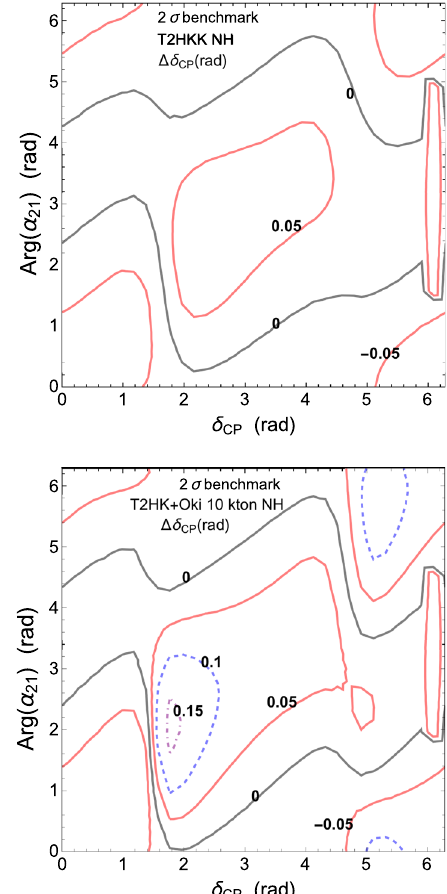
Fig. 13 The difference between the true value of δ CP , and the value that minimizes χ 2 ((cid:20)) of Eq. (32) with the true mass hierarchy. The benchmark with Eq. (37) is assumed, and the true mass hierarchy is nor- mal. The upper-left, upper-right and lower-right subplots correspond to the T2HK, the T2HKK, and the plan of the T2HK plus a 10 kton water